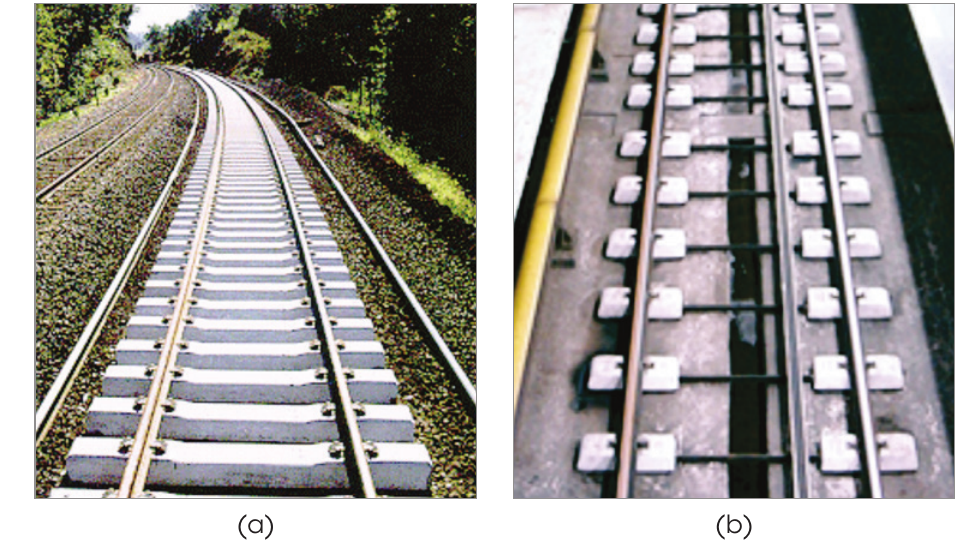
Pathway: (a) mono-block sleeper, PANDROL [21] e (b) bi-block sleeper, Revista